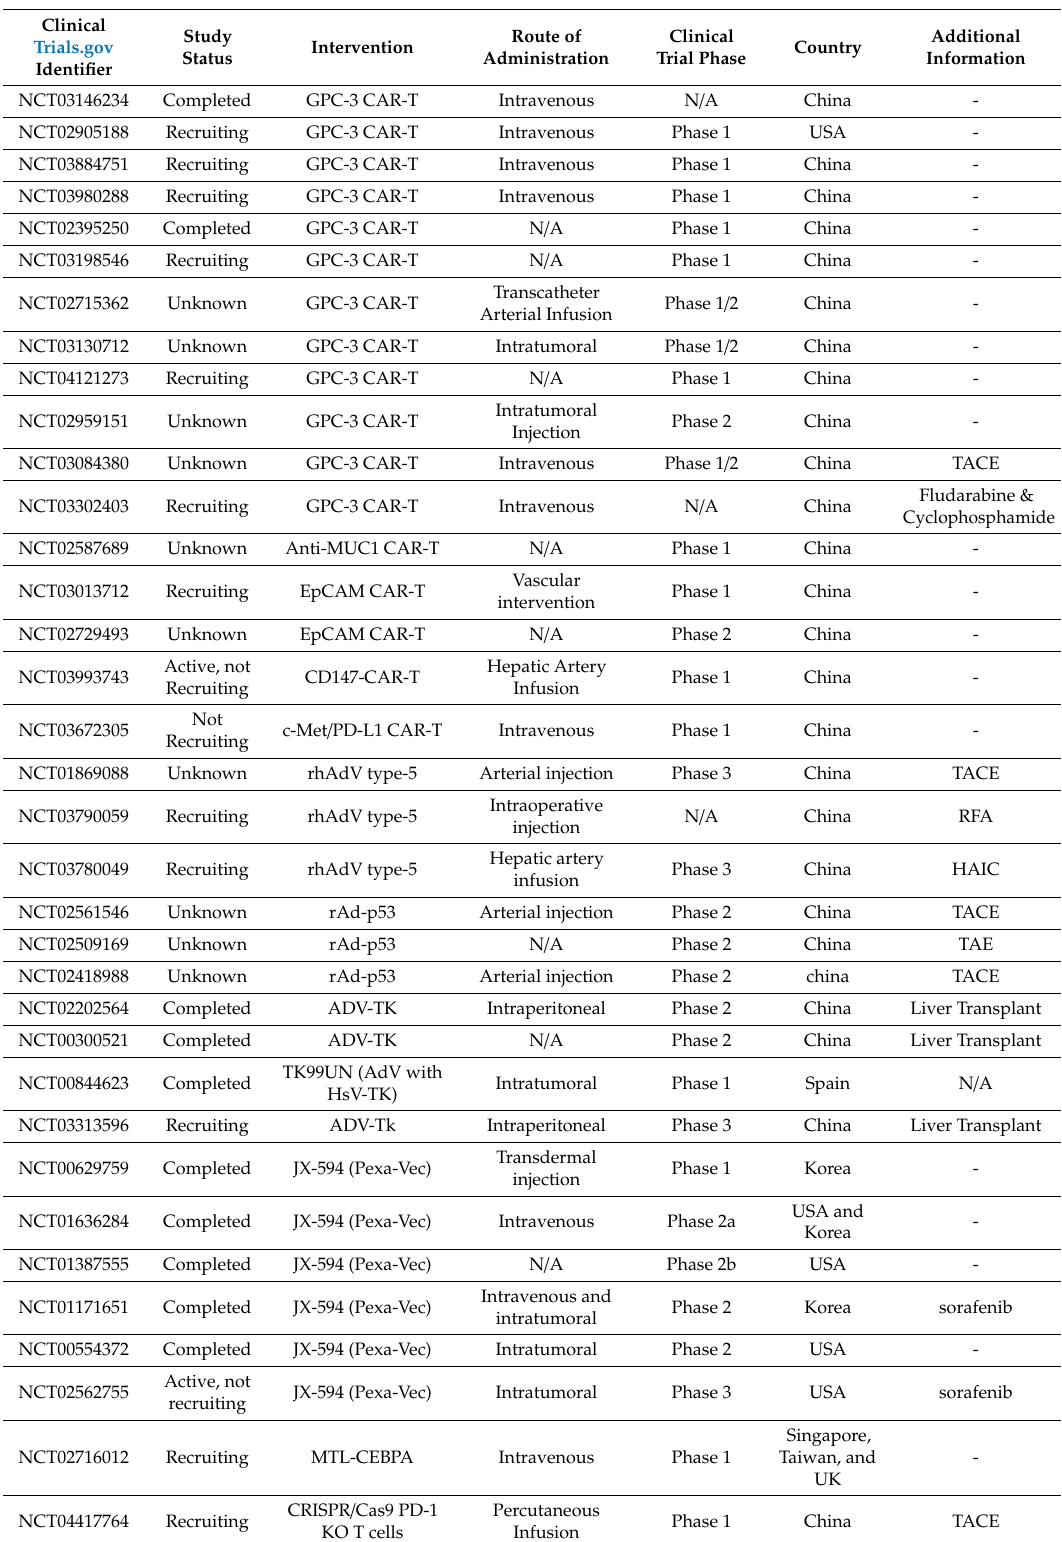
Table 1. Data collected from clinicaltrails.gov as of 8.25.2020 of clinical trials that use CAR-T cells, adenoviruses, JX-594 (Pexa-Vec), lipid nanoparticles, and CRISPR / Cas9 gene therapy to treat Hepatocellular carcinoma